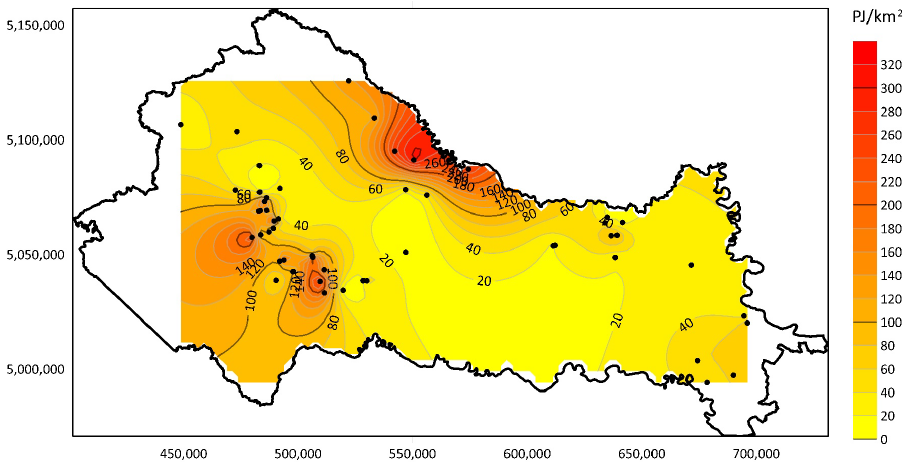
Figure 16. Mean heat-in-place areal distribution—post-rift phase.